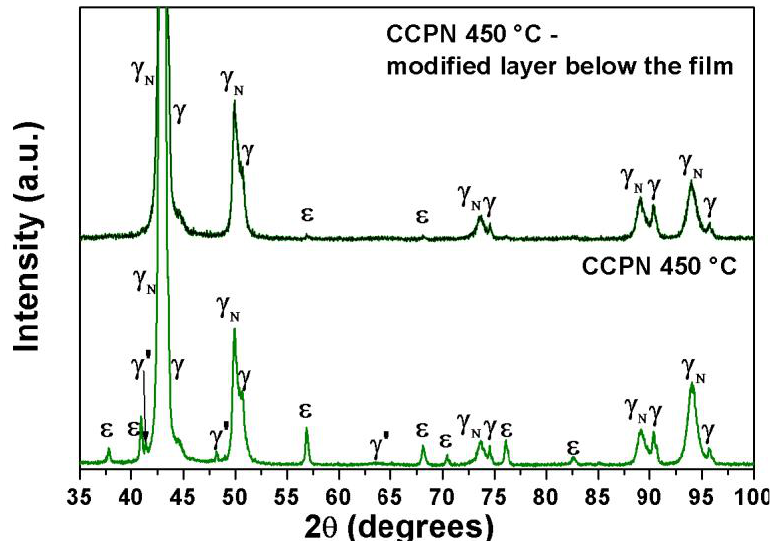
Figure 8. X-ray diffractograms of the CCPN 450 °C sample for the nitrided layer and in the modified layer below the film deposited.